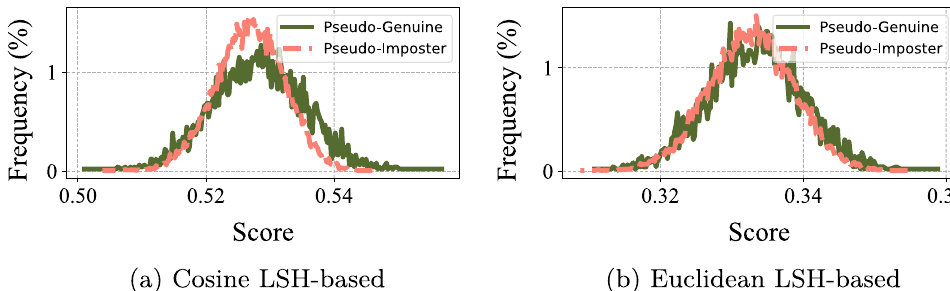
Fig. 13 The pseudo-genuine and pseudo-imposter score distributions of CASIA database with k = 10,000 , d = 2 , n = 2 , N = 2